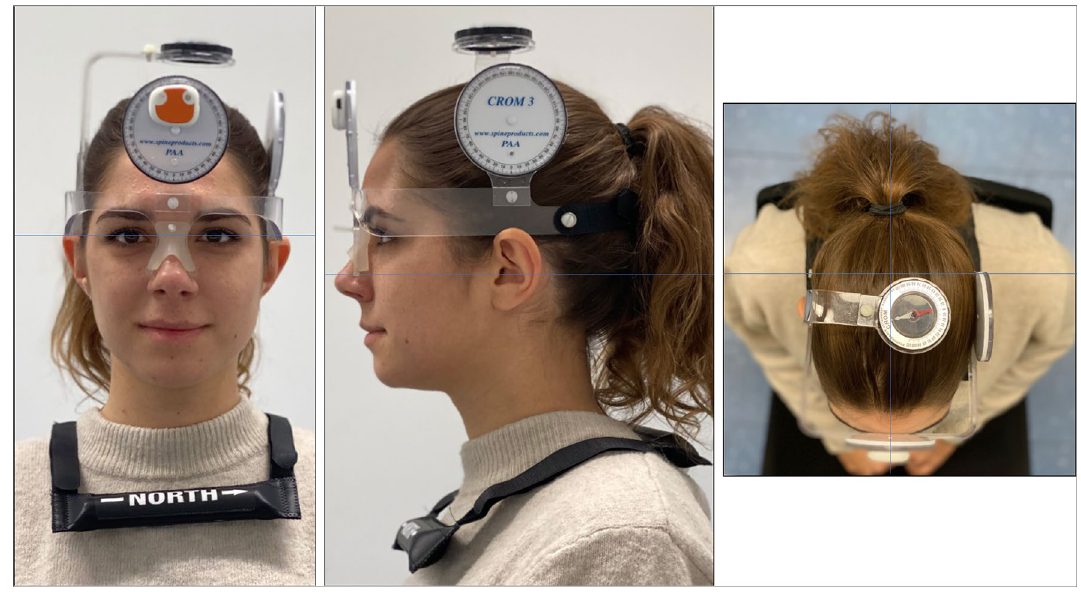
Figure 1. Photograph of the setup used for the in vivo assessment of validity of the inertial measurement unit. The cervical range of motion device was placed on the head with the first sensor fixed on the roll inclinometer and the second one placed on the ground acting as the